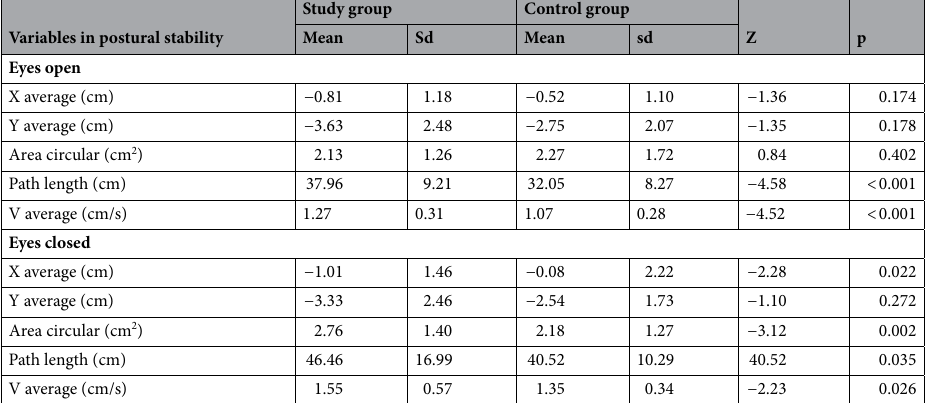
Table 2. Results of postural stability measurement on the platform with double-leg support in study and control groups. Z Mann–Whitney U-test result, sd standard deviation, X average average load point X which determined lateral coordinates X (cm), Y average average load point Y which determined the anterior– posterior coordinates Y (cm), V average average COP velocity (cm/s), p significance level, p < 0.05 reflects statistically significant relationship, p < 0.01 reflects highly significant relationship, p < 0.001 reflects very highly significant relationship.